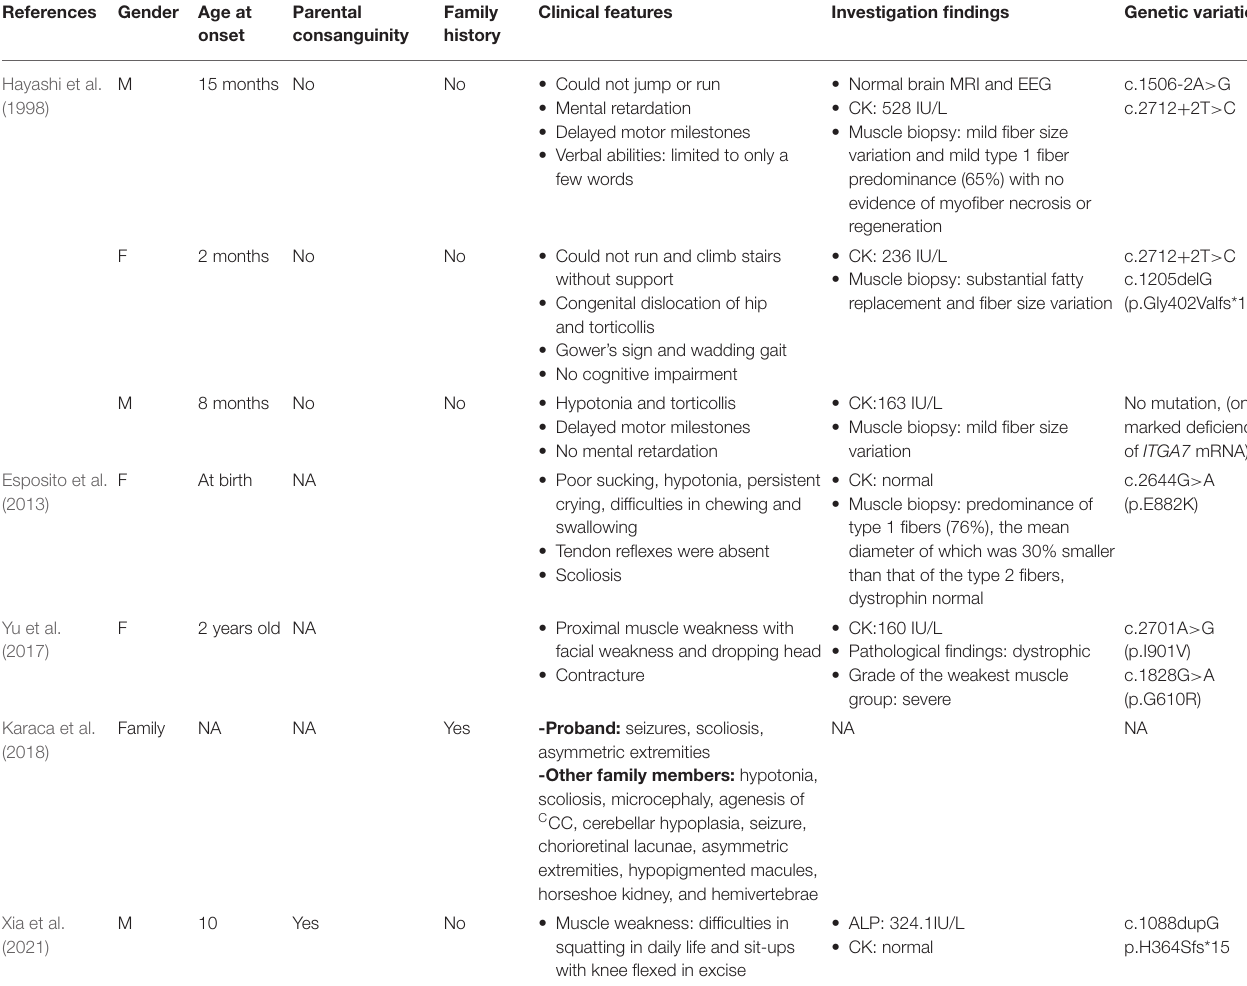
TABLE 1 | Characteristics of CMD induced by ITGA7 mutation